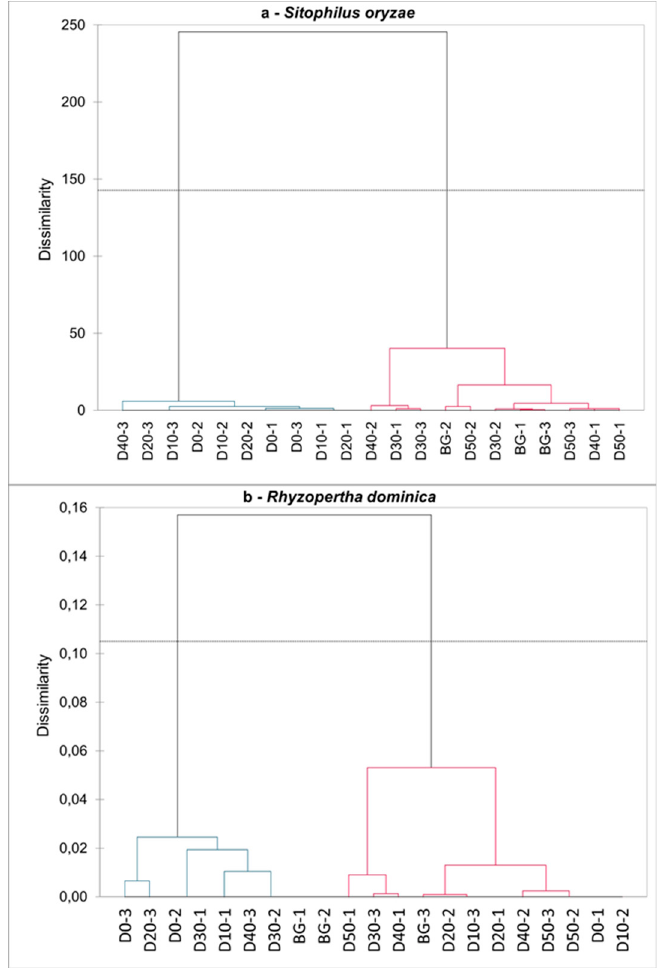
Figure 4. Agglomerative hierarchical clustering (AHC) dendrogram showing dissimilarity between samples based on lethal test values (( a ): S. oryzae , ( b ): R. dominica ).